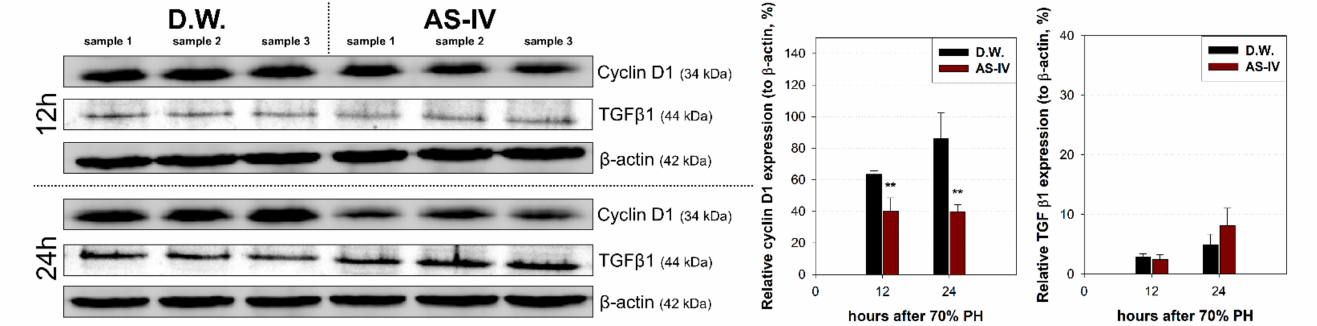
Figure 6. Relative expressions of cyclin D1 and TGF β 1. Expression of cyclin D1 and TGF β 1 were analyzed by Western blot analysis. 12 h after PHx, cyclin D1 expression decreased in the experimental group and decreased further by 24 h while showing increased TGF β 1 expression. Relative protein expressions are presented as a ratio of the β -actin loading control. (mean ± standard deviation, n = 3, **: p <